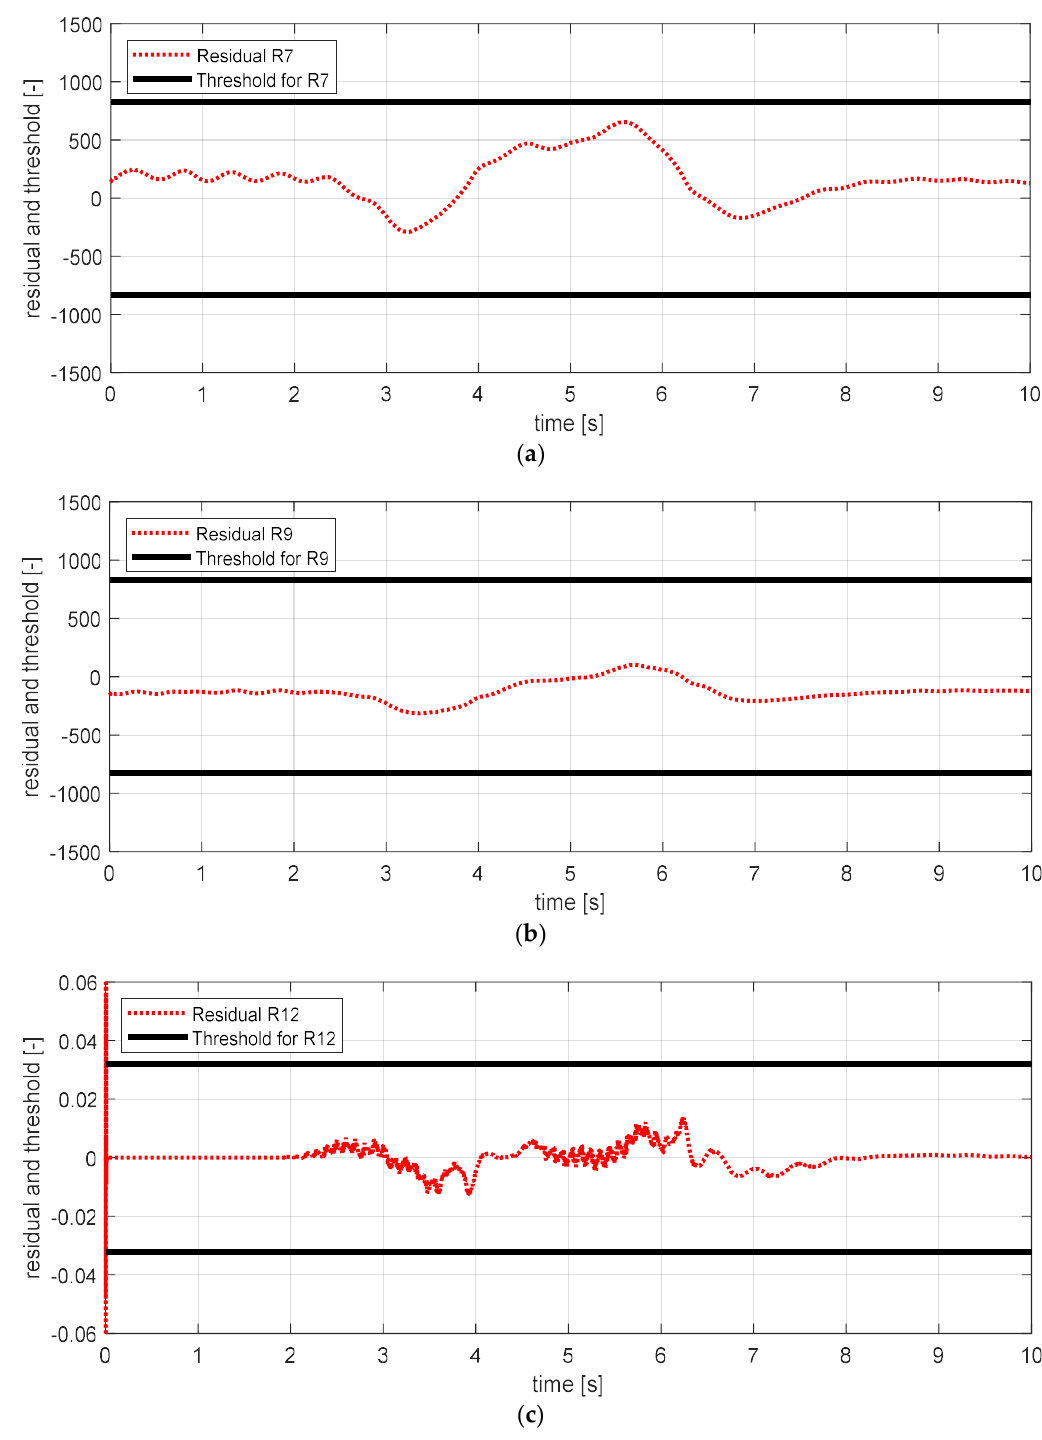
Figure 29. Simulation result for body vertical acceleration sensor—fl (normal). ( a ) Residual 7 and threshold; ( b ) residual 9 and threshold; ( c ) residual 12 and threshold.